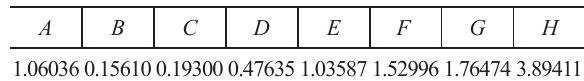
Table 2 – Parameters required for calculating collision inte- gral 63 A